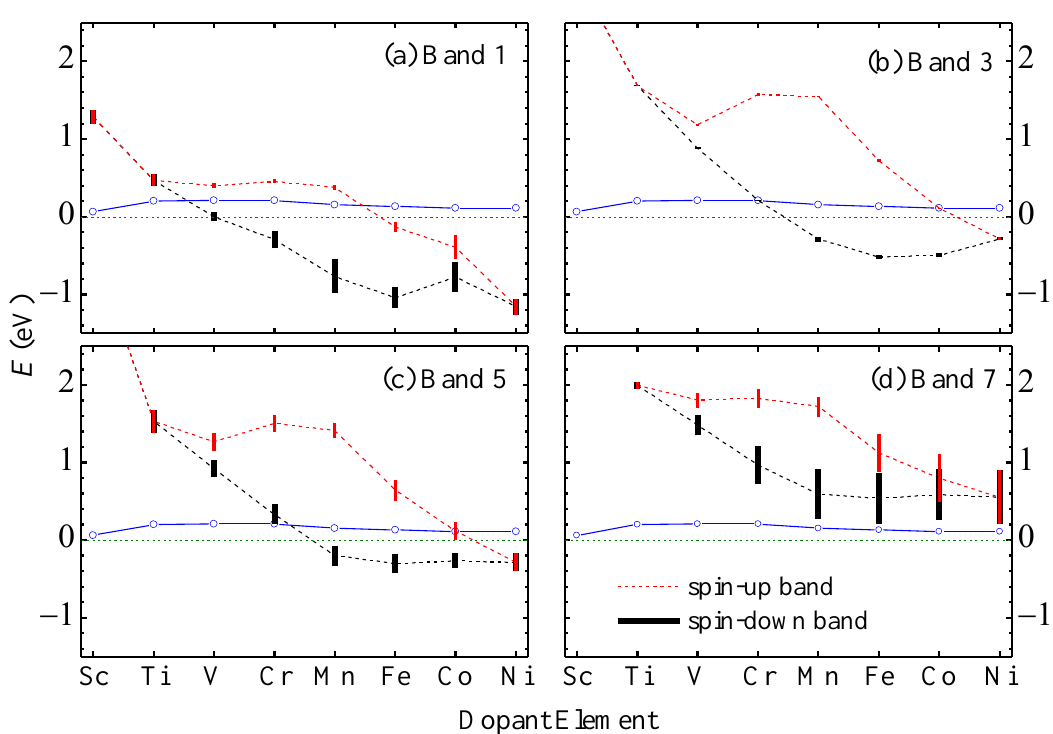
Figure 4. The medium energy (dashed lines) measured from the top of band 2 and the band width (vertical bars) of the spin-up (black) and spin-down (red) branches of ( a ) band 1, ( b ) band 3, ( c ) band 5, and ( d ) band 7 in TM-aMoSiNNRs. The blue empty circles indicate the Fermi energies at low temperature.